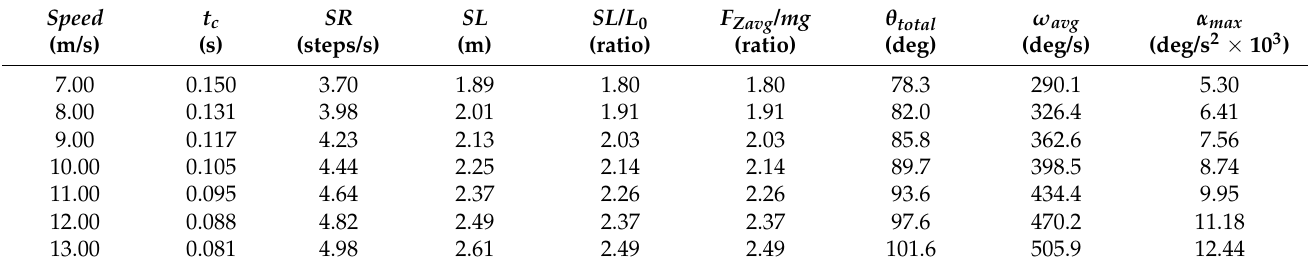
Table 3. Calculated values across a range of speeds for a hypothetical athlete with L 0 = 1.05